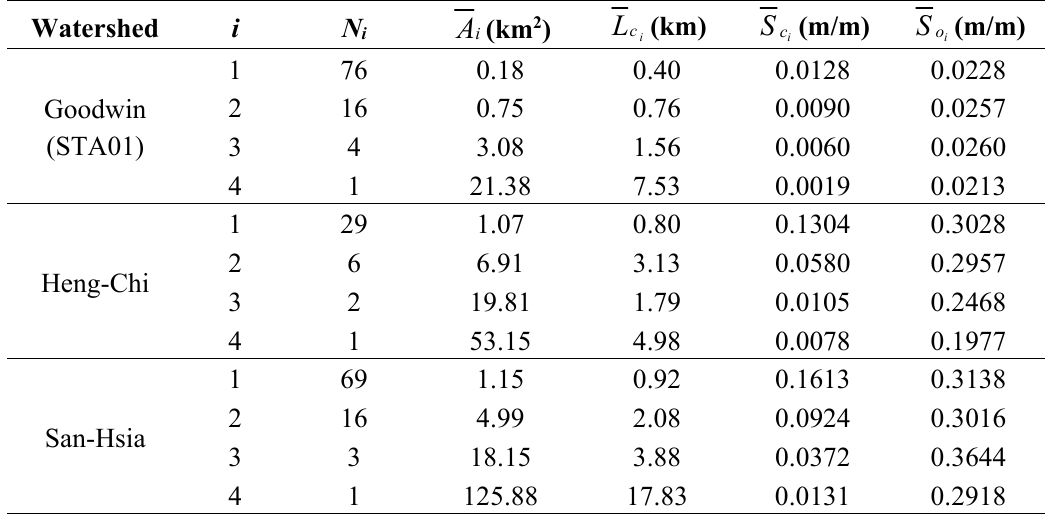
Table 1. Geomorphologic factors of the study